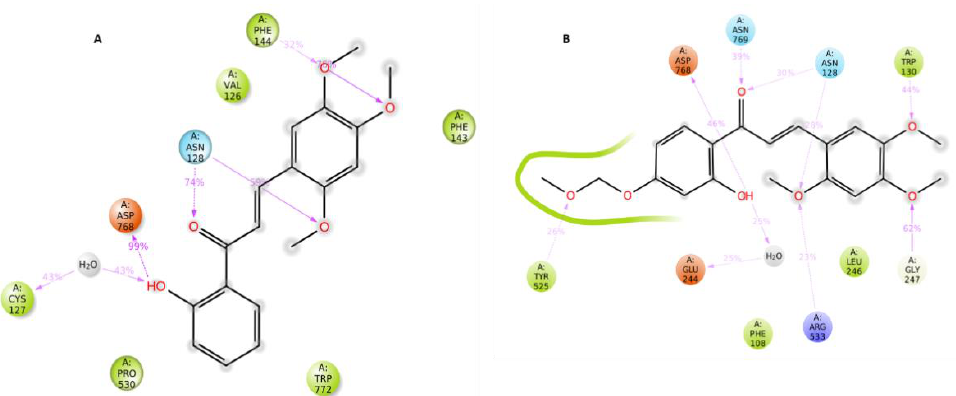
Figure 3. Schematic illustration of LOX-1 interactions throughout the simulation time (10 ns) with ( A ) Compound 3b and ( B ) Compound 3c . Interactions that occur more than 20% of the simulation time are presented. Hydrogen bonds are illustrated with pink color lines. Figure made with Desmond software [66].